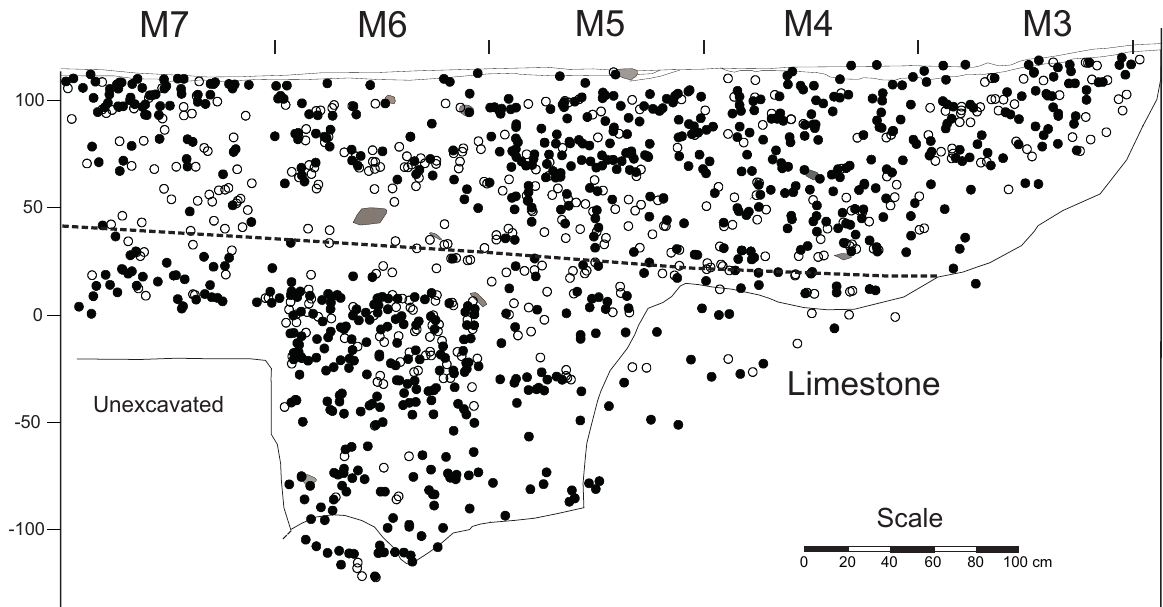
Figure 5 - Spatial arrangement of the lithics (black circles) and faunal (open circles) remains, backplotted against the East profile of the “M Units”. Dotted line shows the approximate limit between early and middle Holocene as defined by the obtained ages.